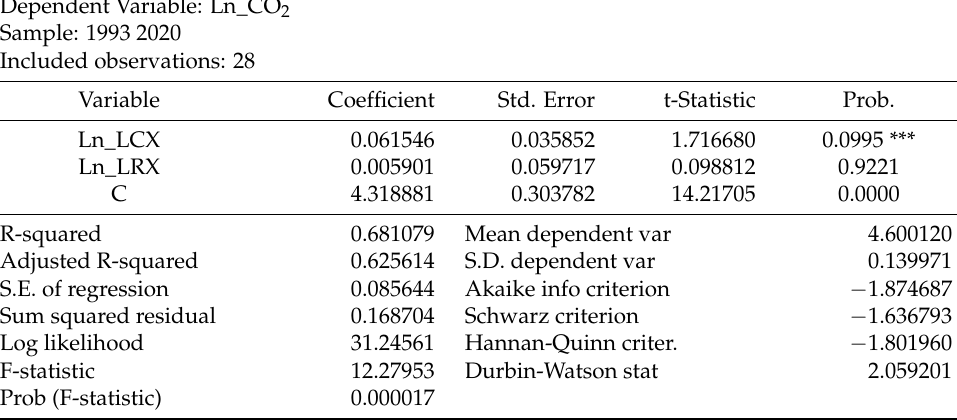
Table 5. Regression